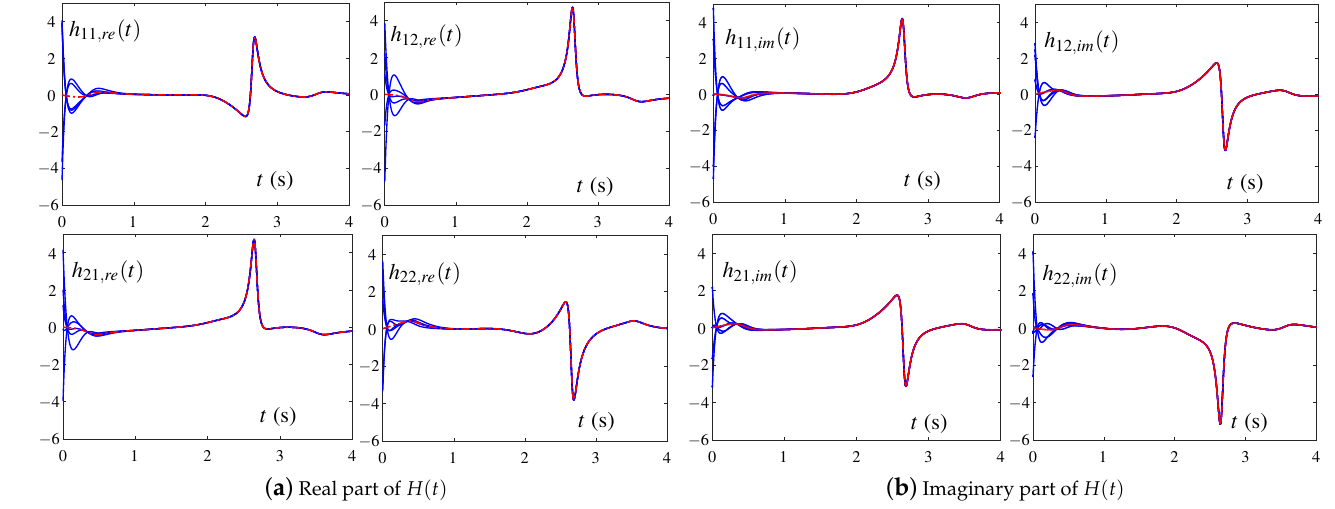
Figure 4. CNRZNN model (7) with ζ = 10 solves CTDLE (15) starting from five initial complex ( 5 + 5 i ) ,5 + 5 i ] 2 × 2 , where the solid blue line represents the state trajectory of H ( t ) and matrices [ − the red dotted line stands for H ∗ ( t ) . ( a ) Real part of the state matrix H ( t ) . ( b ) Imaginary part of the state matrix H ( t )